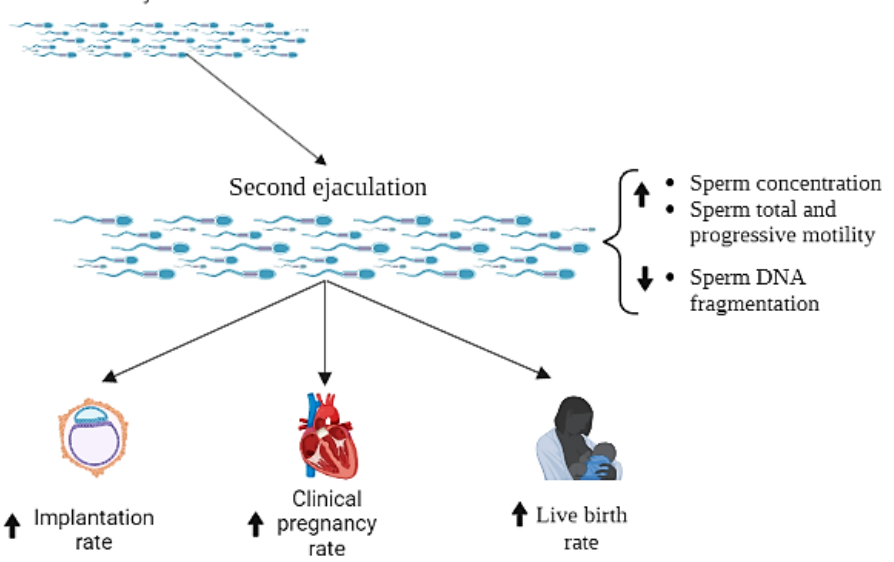
Figure 7. Effects of a second ejaculation performed after a very short period of abstinence from the first on sperm quality and assisted reproductive technique outcomes.